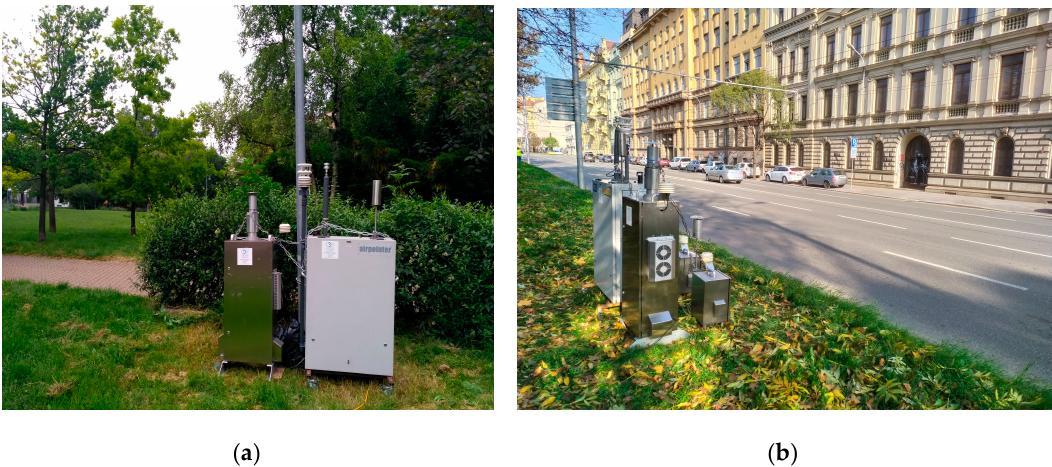
Figure 3. The devices at Kolišt ě : ( a ) Inside the park; ( b ) at the adjacent roadway. Figure 4 shows the location of the sampling sites on a map of Brno.